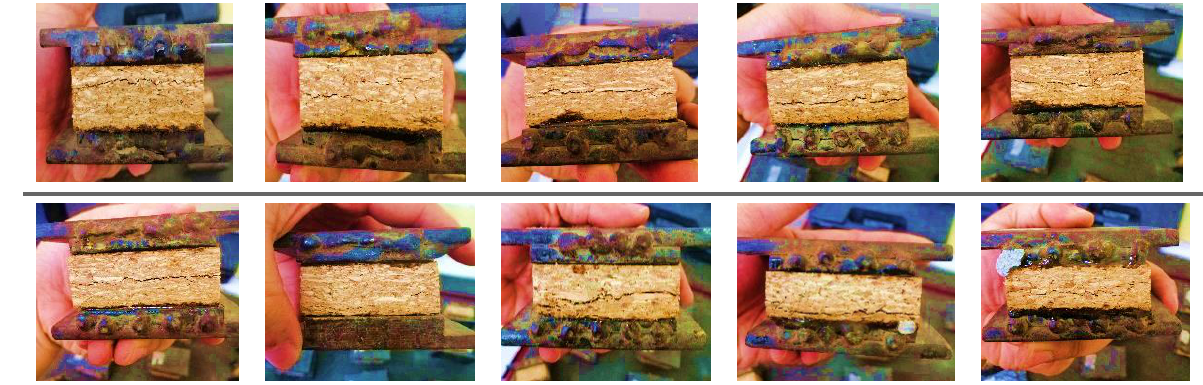
Figure 17. The crack of test pieces after failure for tensile strength.